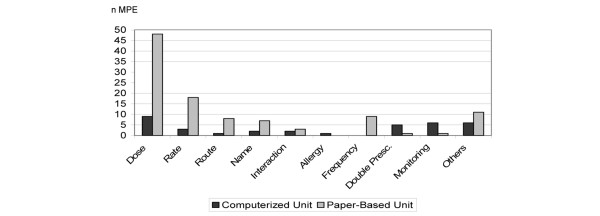
Types of intercepted medication prescribing errors (MPEs) and serious MPEs. Dose, dosing error; Rate, wrong infusion rate of continuous medication; Route, wrong route of administration; Name, error in drug name; Interaction, drug-drug interaction error; Allergy, known allergy to prescribed drug; Double presc., double prescriptions; Monitoring, drug monitoring error; Others, errors in posology, concentration, contra-indication.